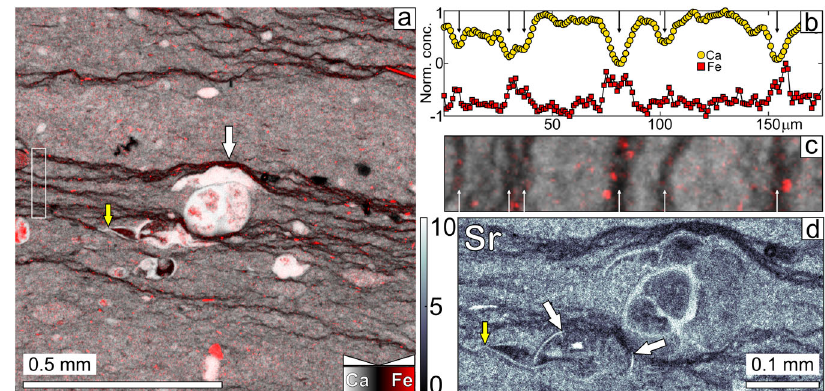
Fig. 3 Micro-dissolution seams in Sample A. a XFM map of the Kaiwhata limestone displaying Ca (grey scale) and Fe (red scale). Bedding is horizontal. The white arrow points to a dissolution structure with a thickness of 20 μ m arrested by the micro-fossil underneath it. Fossils appear as bright white ellipsoidal objects. The white rectangle marks a zone for which normalised averaged elemental pro fi les are plotted in ( b ). b Averaged and normalised pro fi les of Ca and Fe traverse six dissolution structures with Ca depletion and Fe enrichment (black arrows). The Fe pro fi le is shifted down by − 1 for visibility. c Magni fi ed view of the zone for which averaged elemental pro fi les in ( b ) were obtained. The white arrows mirror the black ones in ( b ). The map scale is given in ( b ). d This magni fi ed view of the Sr map of Sample A demonstrates that the dissolution structures are also zones of Sr depletion and truncate fossil shells (white arrows). This map has a horizontal extent of 0.5 mm, and the yellow arrow serves as location reference to the larger map in ( a ). The concentration unit is μ g cm − 2 . The XFM maps used to make this fi gure are provided in Supplementary Data